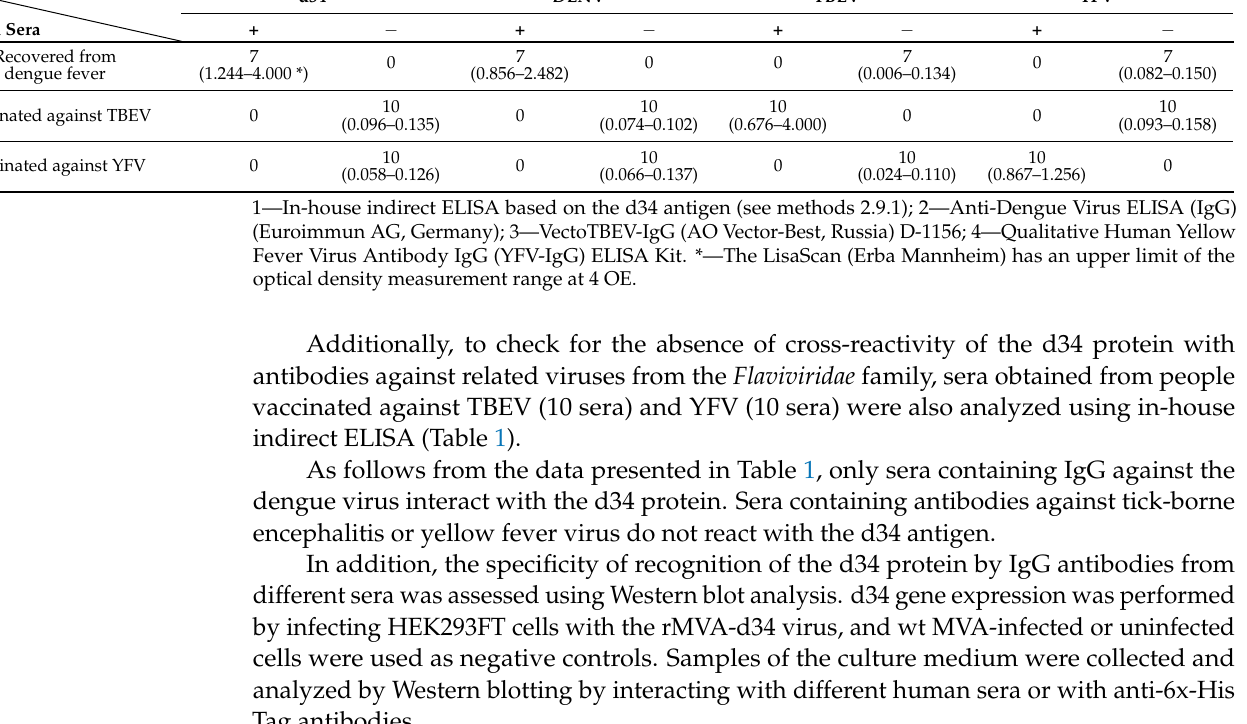
Table 1. Results of studying the reactivity of the d34 antigen with human blood sera containing IgG antibodies against DENV, TBEV, and YFV. For each group of sera, the number of positive and negative samples identified using the corresponding ELISA test is indicated. The ranges of OD450 values for all sera from this group are shown in brackets.